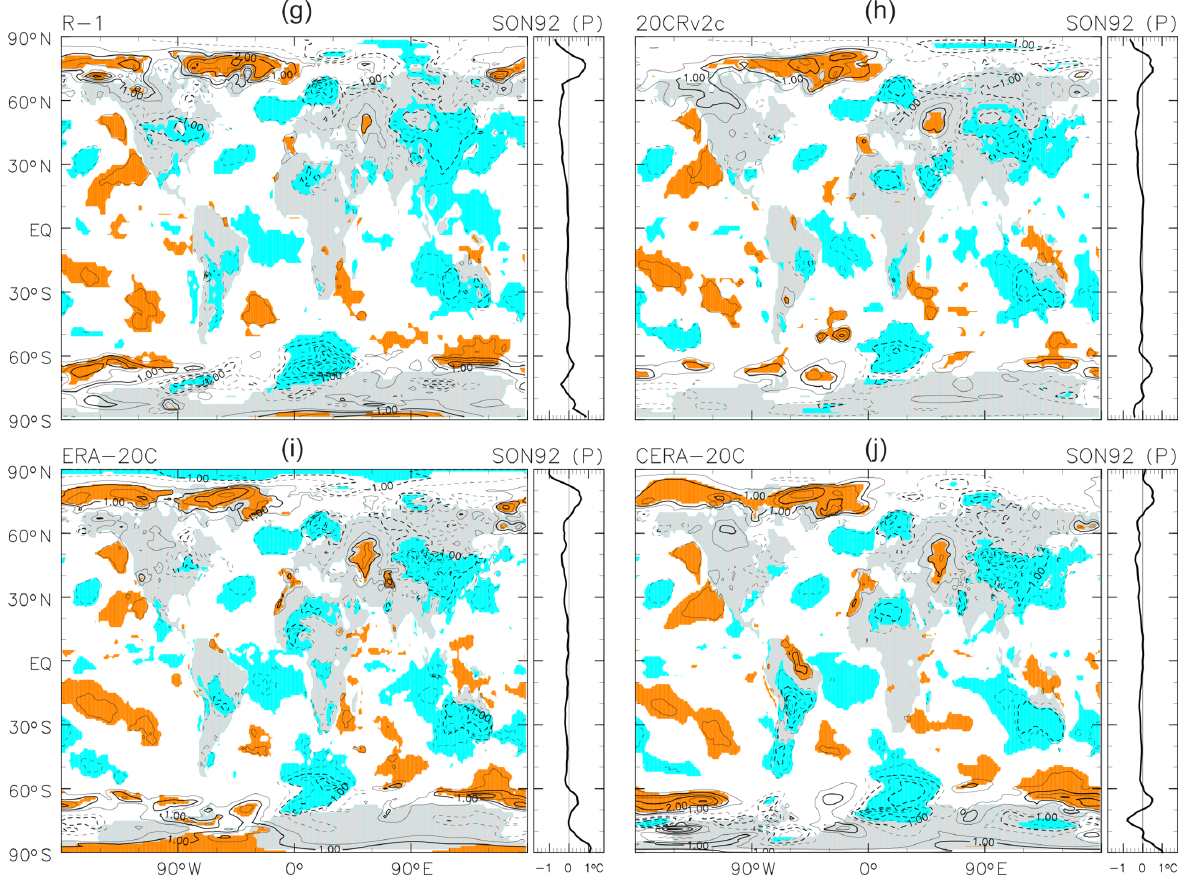
Figure 2. Geographical and zonal-mean distributions of the 2m temperature anomalies averaged for September to November 1992 following the Mount Pinatubo eruption in June 1991. Results are based on the 1980–2010 MLR analyses for each of 10 reanalysis data sets (see the legend at the top of each panel). Solid and dashed contours denote positive and negative anomalies, respectively. The contour interval is 0.5K, without 0.0K lines. Coloured shading denotes anomalies that are positive (orange) or negative (blue) with magnitudes exceeding 1 standard deviation (SD) of the 3-month mean R(t) at that